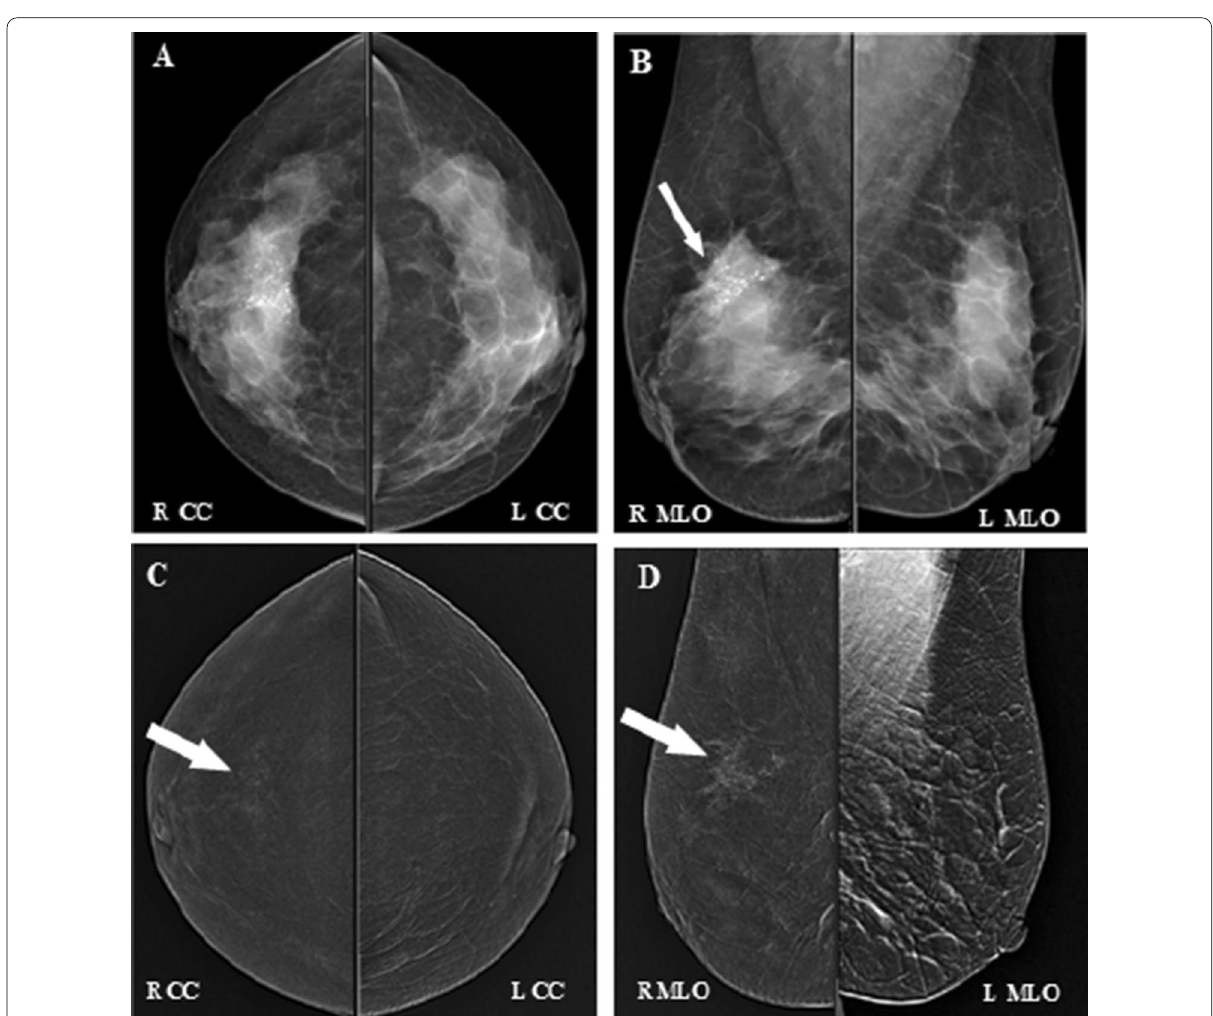
Fig. 1 A 42-year-old female, complaining of right breast pain. (A) Craniocaudal mammographic view of both breasts, and (B) Mediolateral mammographic views of both breasts revealed right upper quadrant single view asymmetry (arrow) seen at right MLO view associated with right upper outer quadrant segmental fine pleomorphic calcifications. (C) Craniocaudal CEM view of both breasts, and (D) Mediolateral CEM views of both breasts revealed right upper outer quadrant clumped segmental non-mass enhancement. Pathology revealed low-grade DCIS. CEM confirmed the malignant nature of right upper outer quadrant lesion and showed its actual extension